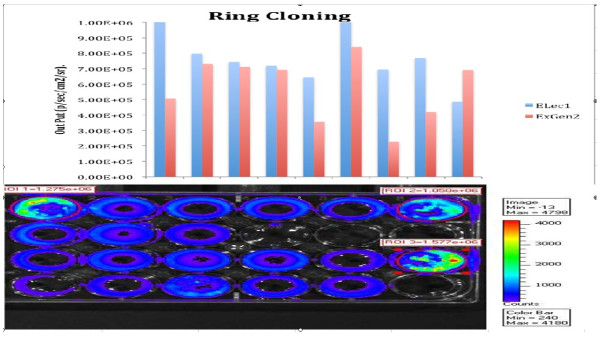
Nine independent clones of DLD1/SV-rLuc/ExGen2 and of DLD1/SV-rLuc/ELec1 were transferred from patri dishes to the 24-well plates at and treated with coelenterazine 25 μg/ml after overnight incubation. Output (p/sec/cm2/sr) was immediately quantified using IVIS machine.